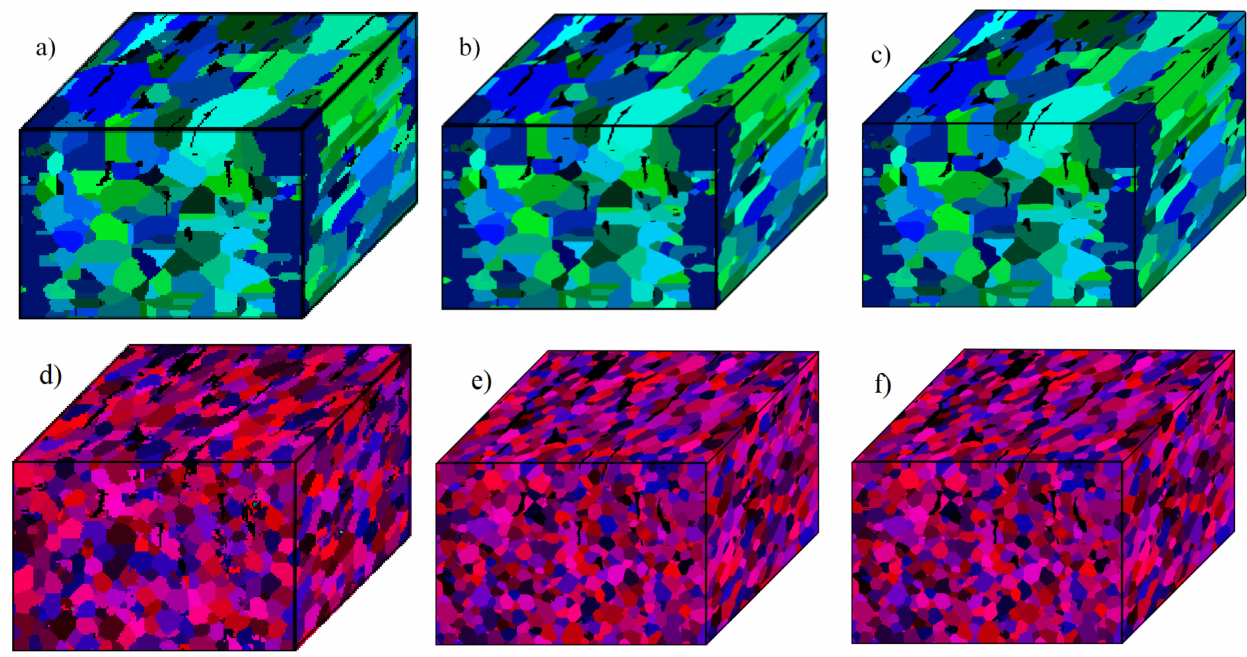
Figure 11. Initial material morphology after scaling to ( a ) 150 × 87 × 101, ( b ) 300 × 175 × 202, ( c ) 600 × 350 × 404 cells and corresponding results of static recrystallization simulation ( d – f